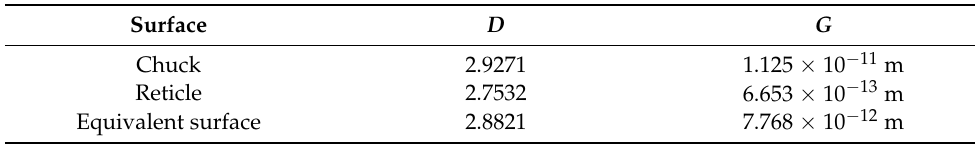
Table 1. D and G confirmed by 3D-RMS method.